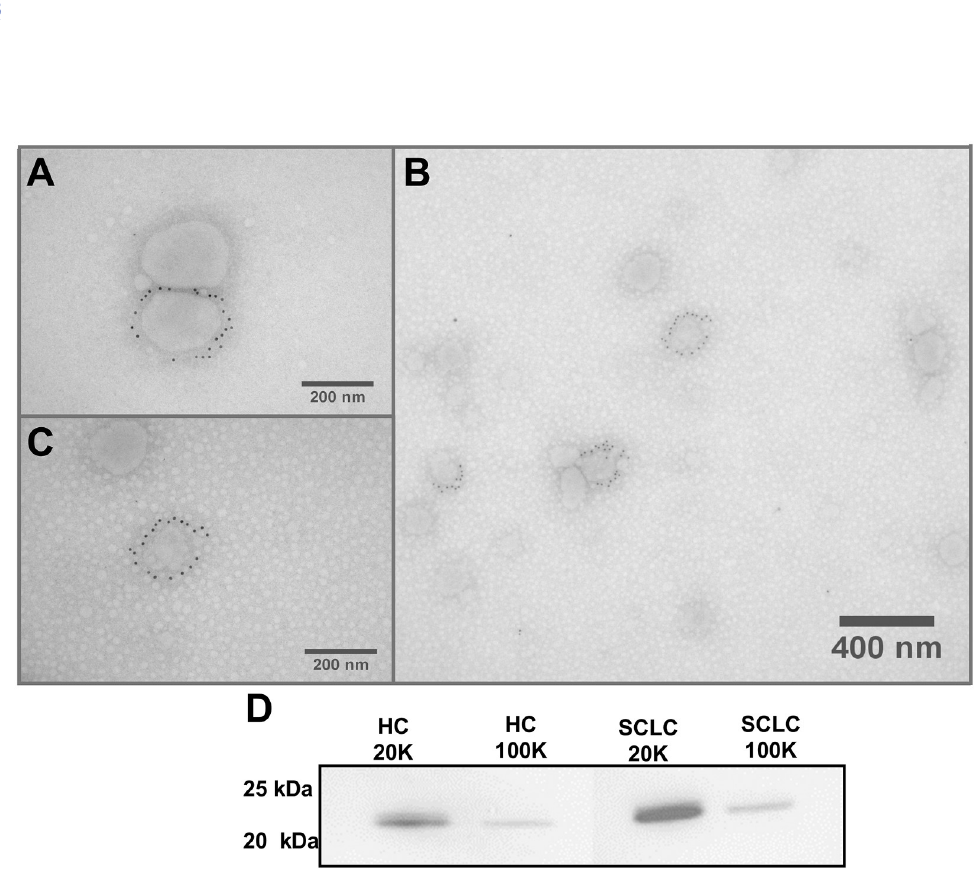
Fig 1. EV confirmation and validation. Immunoelectron microscopy (IEM) and Western blot analysis of extracellular vesicle marker CD9 performed on a pool of isolated vesicles from all donors. A) 20K pel CD9 positive vesicles. B) Both CD9 positive and negative vesicles isolated for the 100K pel. C) 100K pel CD9 positive vesicle. D) Western blot analysis against CD9 for the 20K and 100K EV pellets from healthy controls (HC) and small cell lung cancer patients